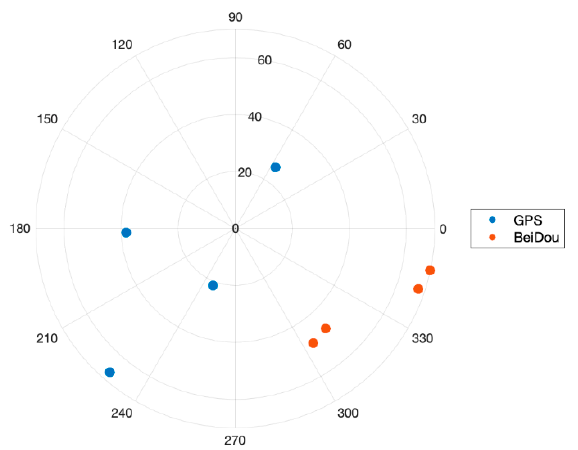
Figure 12. Sky plot of the GPS and BeiDou satellites taken at at Hongik University on 22 December 2020. There were a total of eight GPS and BeiDou satellites in view, which represents a GNSS harsh environment.